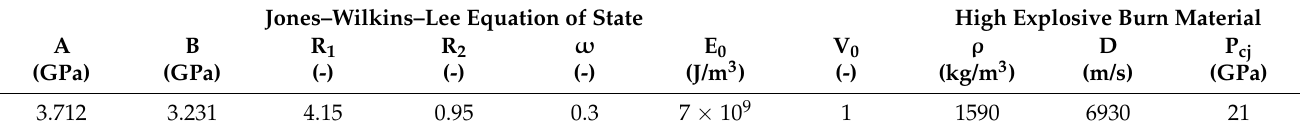
Table 7. Parameters of JWL EOS and High Explosive Burn Material model of TNT.